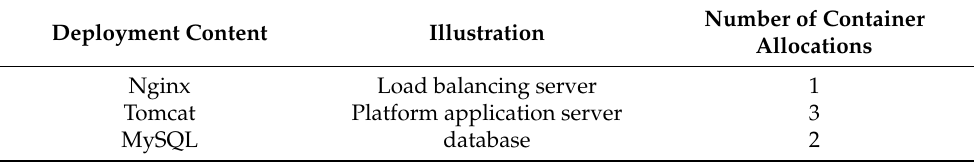
Table 3. Container deployment allocation.